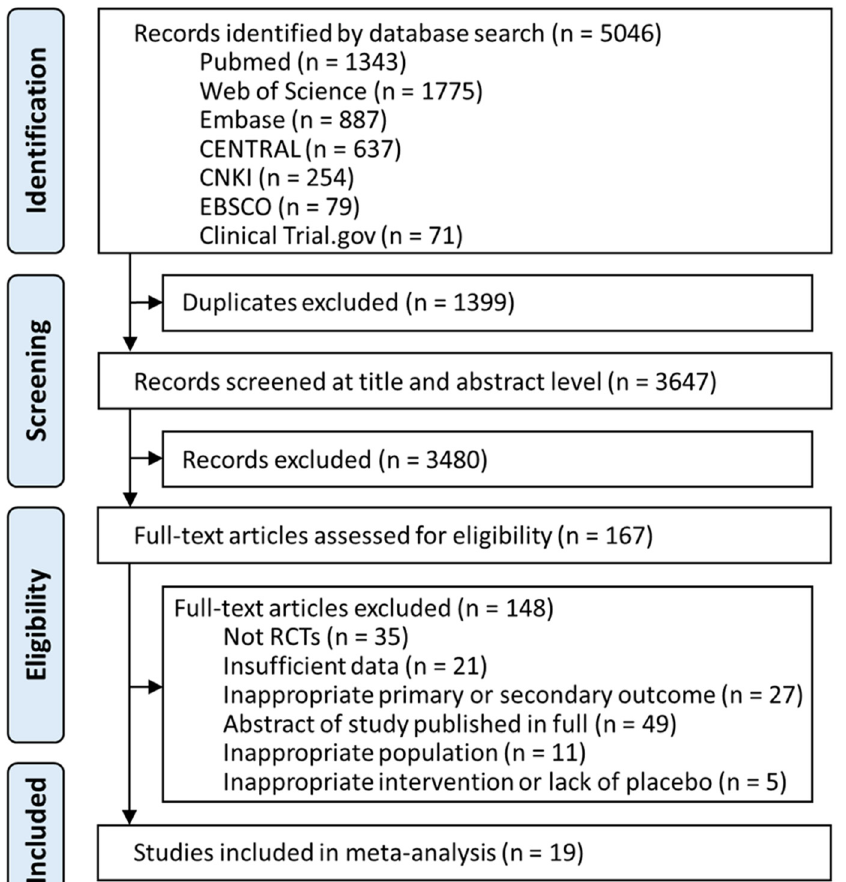
Figure 1. Summary of study selection. Figure demonstrates the flow of retrieval and identification of included trials. Overall, six pharmacological interventions were fitted into the analyses, including armodafinil, lower-sodium oxybate, modafinil, pitolisant, sodium oxybate, and solriamfetol. (Listed in alphabetical order). CENTRAL, Cochrane Central Register of Controlled trials; CNKI, China National Knowledge Infrastructure; EBSCO, Psychology and Behavioral Sciences Collection.